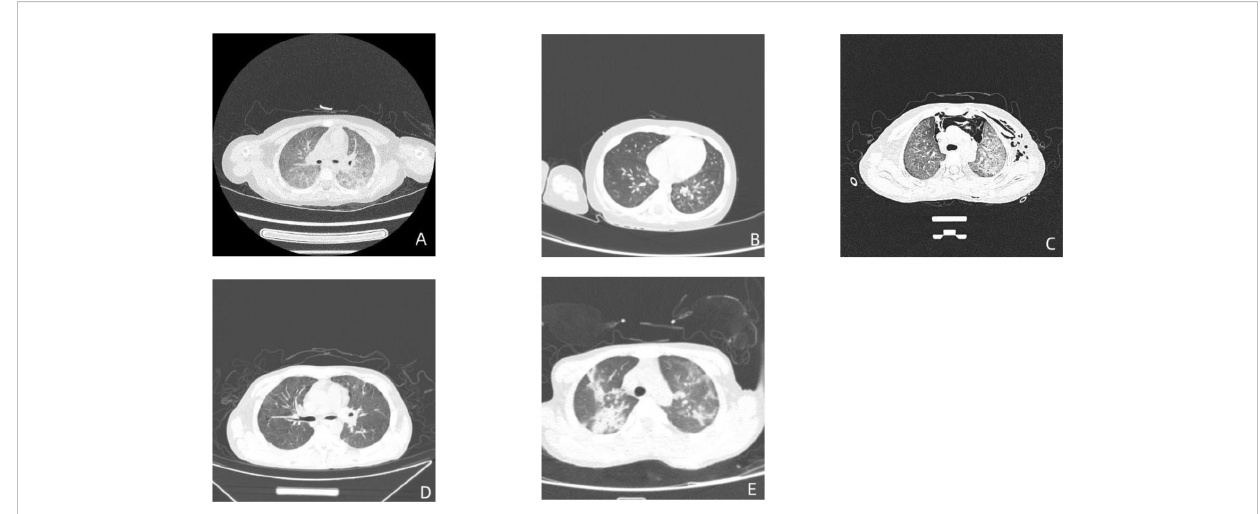
FIGURE 2 Pulmonary CT results in fi ve children. The fi gure (A – E) are the CT images of the lungs of case 1-5 in